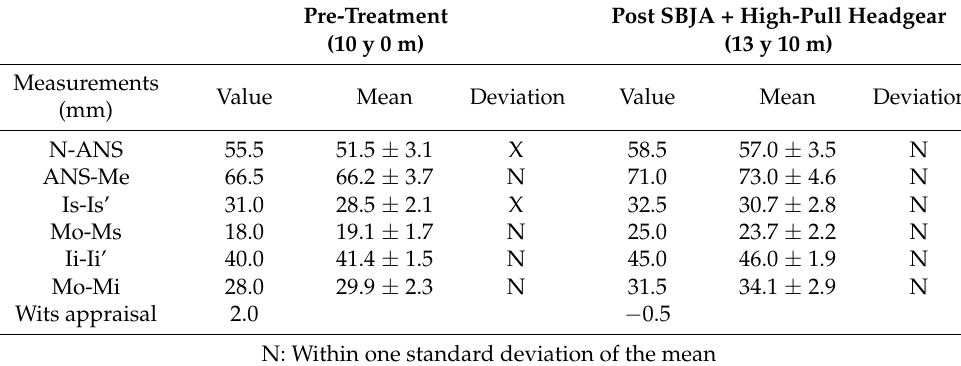
Table 4. Cephalogram distance measurements of Case